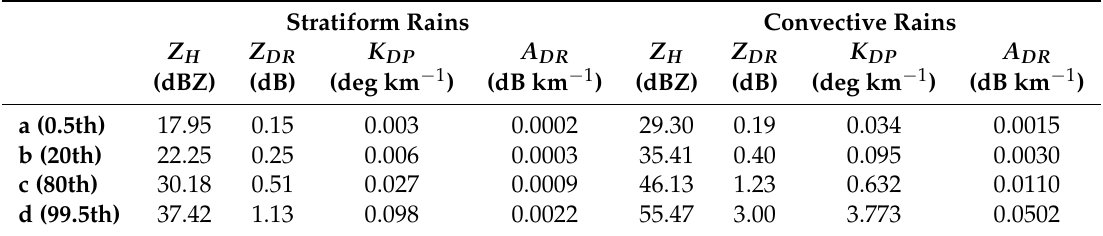
Table A1. The vertex values of the trapezoidal MF for Z H (dBZ), Z DR (dB), K DP (deg km − 1 ), and A H (dB km − 1 ) as presented in Figure